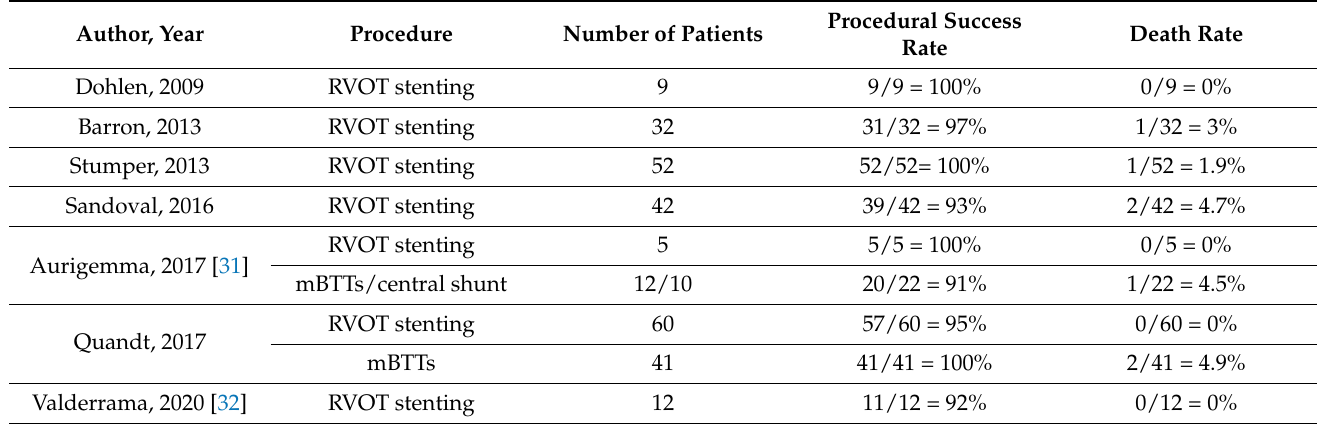
Table 1. The details of studies included in the